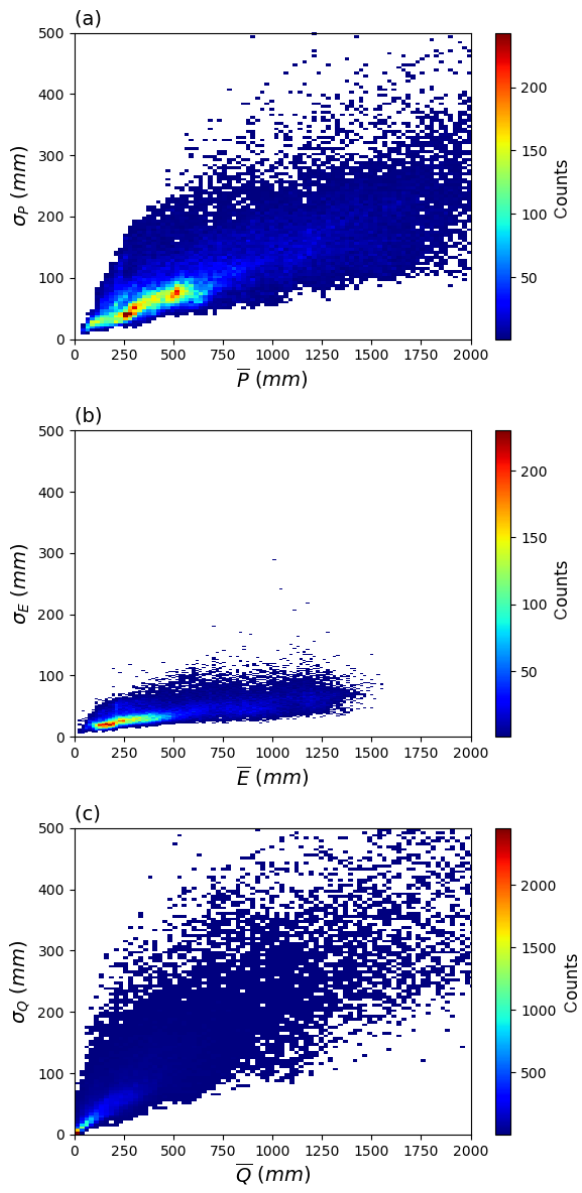
Figure 4. Relation between inter-annual mean and standard devia- tion for (a) P , (b) E and (c) Q from the CDR database. Note that the mean annual (cid:49)S is zero by construction and is not shown.